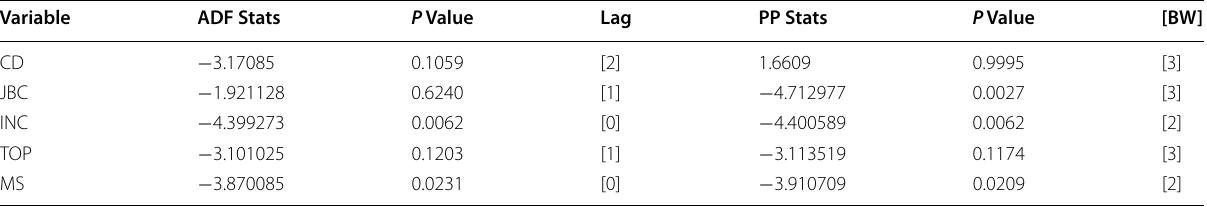
Source Computed using Eviews 9.0 Package